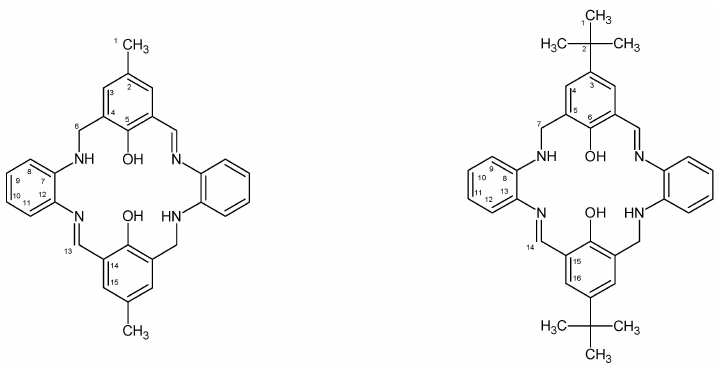
Figure 1. Structural formulas of L1 ( left ) and L2 ( right ) ligands with the numbering